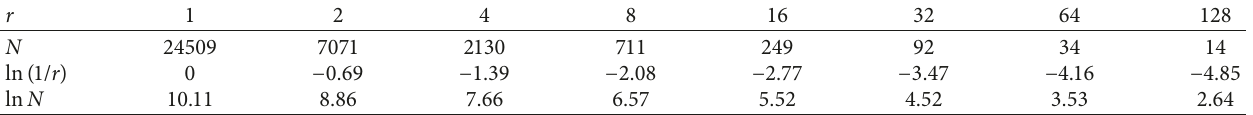
(mining face 5-1 at a mining length of 1200mm). f